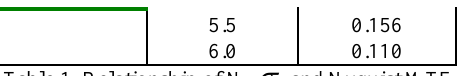
Table 1. Relationship of N,  and Nyquist MTF